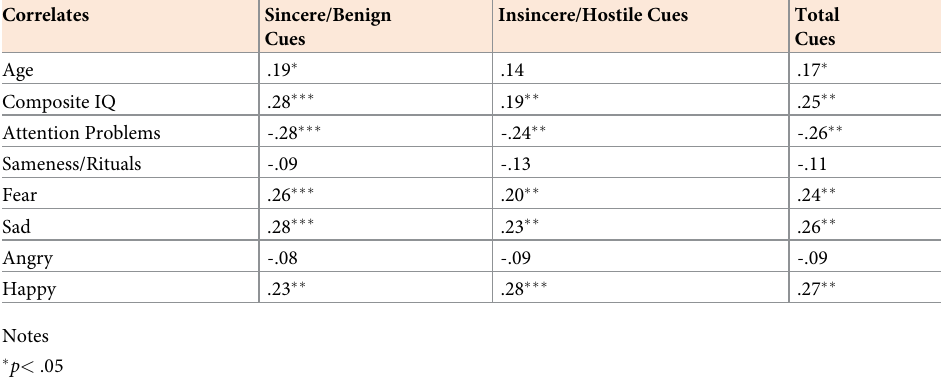
Table 5. Pearson correlations between social perception cue scores and behavioral and emotion recognition